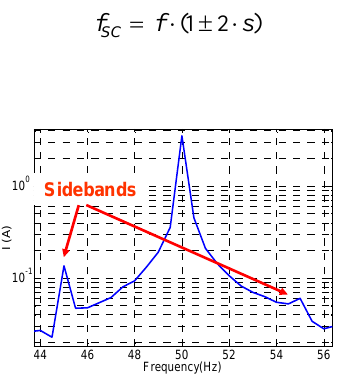
Fig. 1. FFT of the steady state current for a loaded machine with two broken bars.